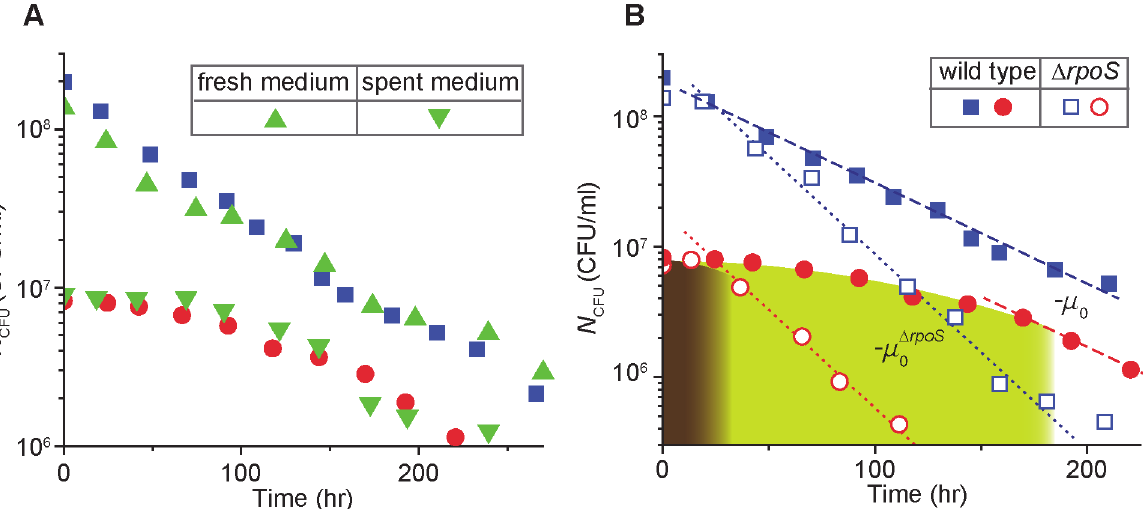
Fig 2. A role of extracellular signaling and rpoS in the density-dependent survival kinetics. (A) A role of extracellular signaling: a high density of exponentially-growing cells ( N CFU (cid:1) 7 (cid:3) 10 8 /ml) was transferred to a fresh medium without glycerol. N CFU of cells in the fresh medium (green triangles) decreases similarly to that from the previous experiment (solid blue squares, re-plotted from Fig. 1). Next, a spent medium was prepared from a culture of a high density of cells. N CFU of cells at low density in the spent medium (green inverse triangles) decreases similarly to that from the previous experiments (solid red circles, re-plotted from Fig. 1). The results indicate that extracellular signaling does not play a role for the density-dependent kinetics. See the text for details. (B) A role of rpoS : Under starvation, N CFU of the Δ rpoS strain (open symbols) decreases faster than that of the wild type strain (solid symbols, re- plotted from Fig. 1); compare the slope of the dotted line − μ o Δ rpoS (= − 0.035 hr -1 ) and the slope of the dashed line − μ 0 (= − 0.018 hr -1 ). See also S6 Fig for Δ rpoS strain. Importantly, in the low cell-density cultures (e.g., open red circles), the periods during which N N CFU of other densities of the CFU is maintained are much shorter for the Δ rpoS strain (brown region) than for the wild type strain (green region); note that here the brown and green regions are approximately determined as regions where the survival kinetics does not follow exponentially decay. This indicates that rpoS plays an important role for the wild type strain to maintain N CFU for extended periods of time in low density under